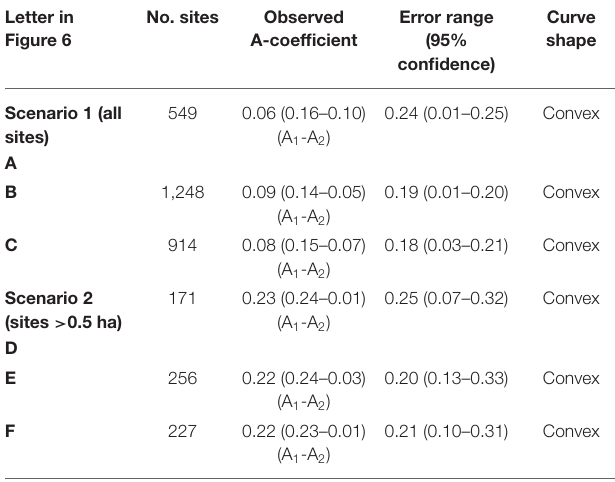
TABLE 2 | A-coefficient values and bootstrapped error ranges for log scale rank-size curves in Etruria during the Iron Age/Orientalizing ( Figures 6A,D ), Archaic ( Figures 6B,E ), and Post-Archaic periods ( Figures 6C,F